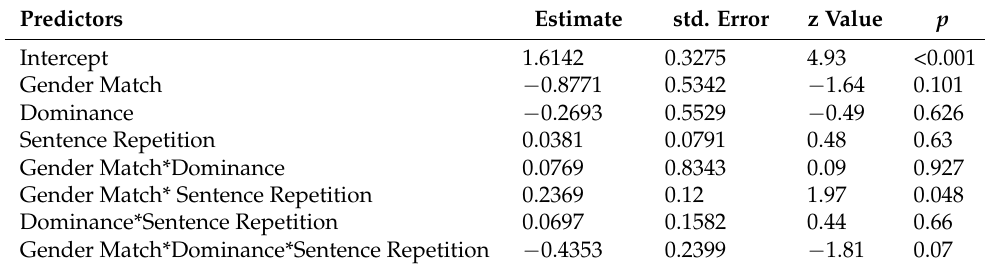
Table A8. Summary of the model for accuracy and the effect of sentence repetition and language dominance in the production task for the bilingual children.